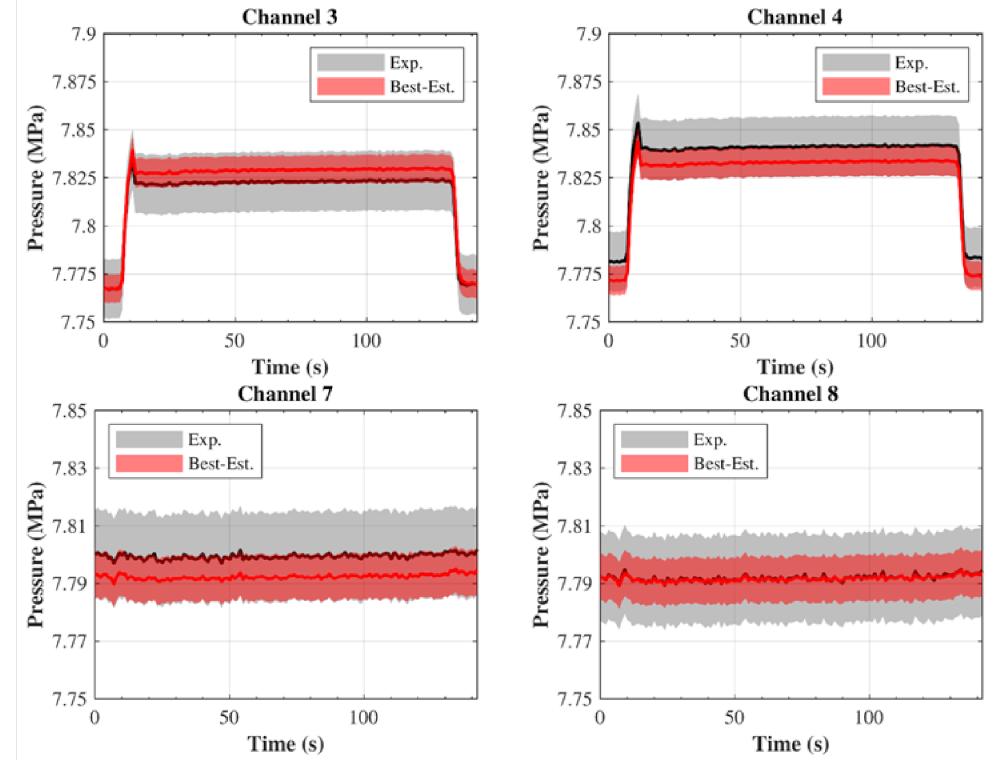
Figure 6. Outlet coolant pressure—300 kW/m 2 , 40% valve opening